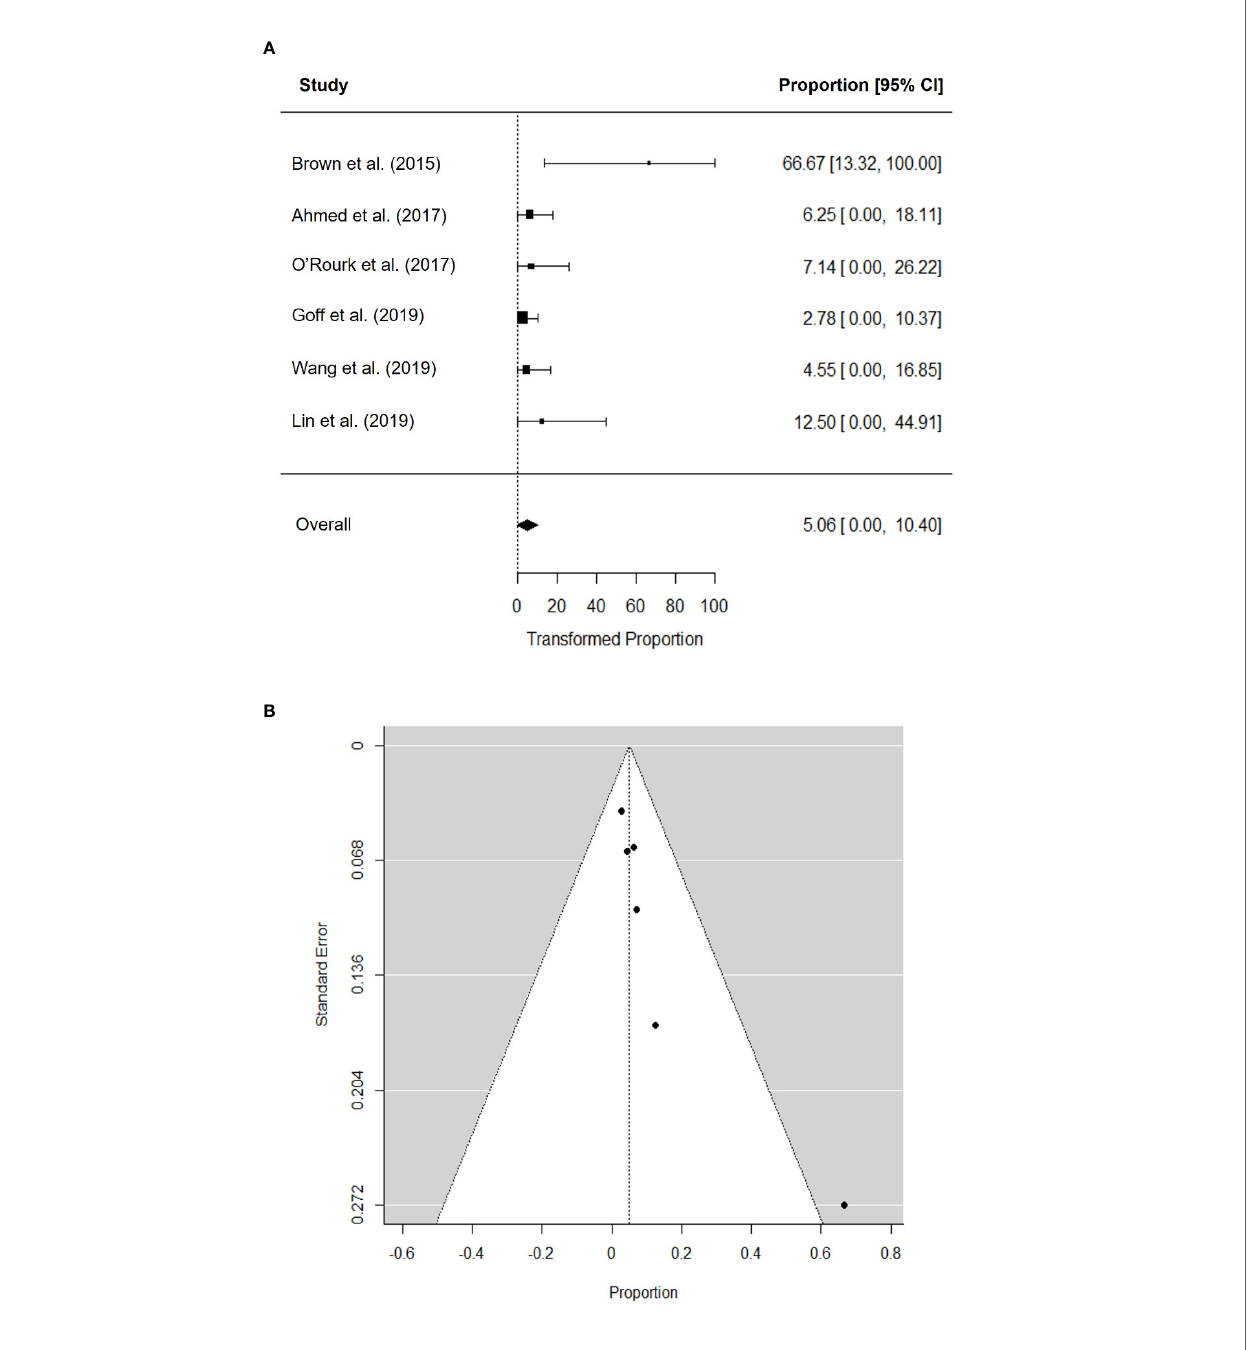
FIGURE 2 | Forest plot for objective response rate (A) and funnel plot of publication bias in objective response rate (B)